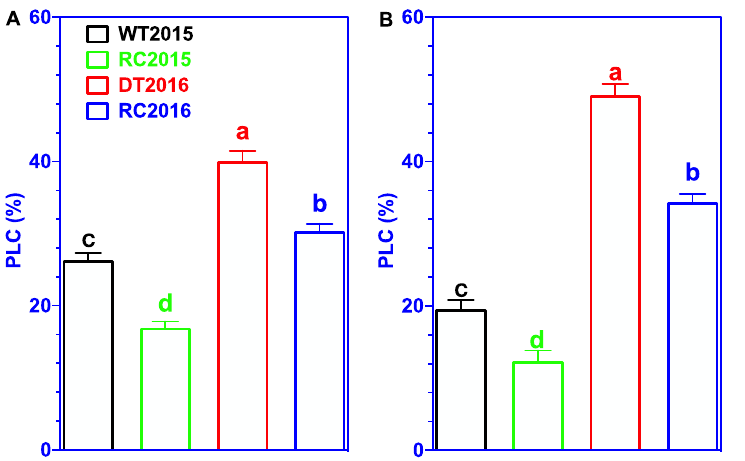
Figure 6. The percentage loss of hydraulic conductivity (PLC) in branches ( A ) and roots ( B ) of Robinia pseudoacacia under different treatments. Different letters indicate a statistically significant difference at p < 0.05 between stand age treatments. Error bars represent ±1 SD. WT2015 is wet year of 2015 without in situ rainwater collection and infiltration system; RC2015 is wet year of 2015 with in situ rainwater collection and infiltration system; DT2016 is dry year of 2016 without in situ rainwater collection and infiltration system and RC2016 is wet year of 2016 with in situ rainwater collection and infiltration system.